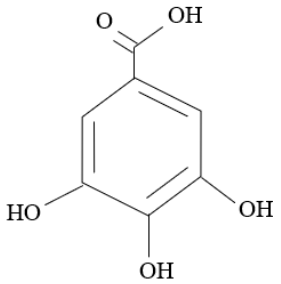
Figure 9. Backbone unit of tannins.